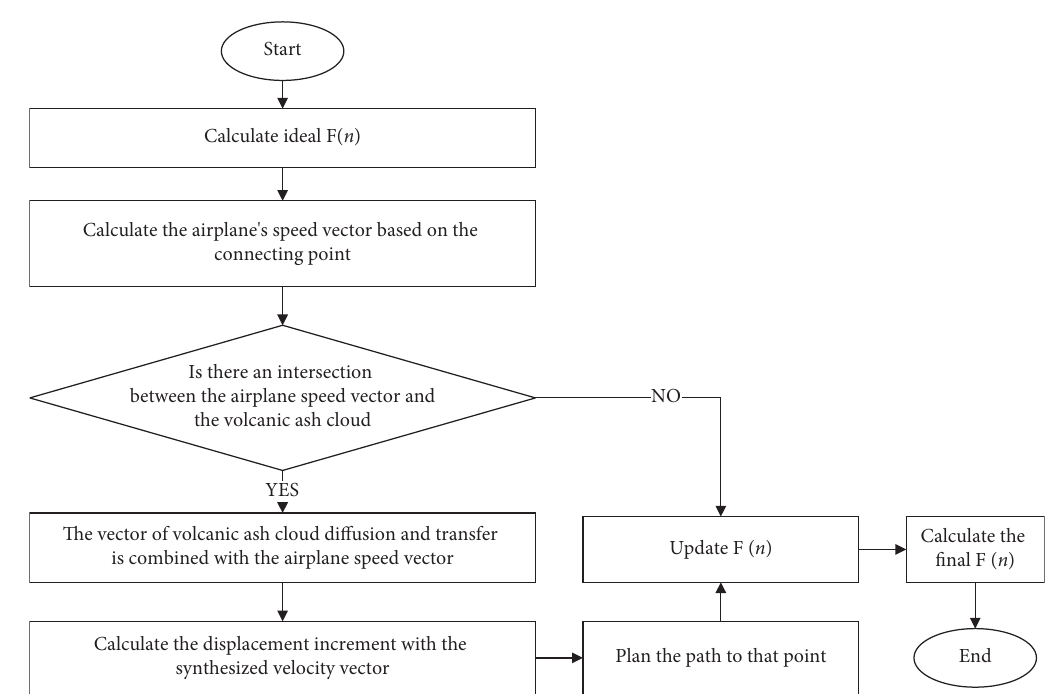
Figure 6: Technical path of the improved A-star algorithm for velocity